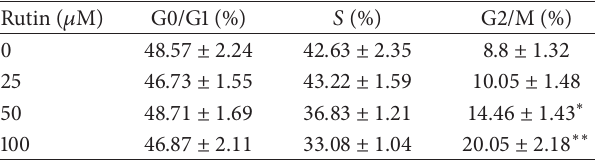
Table 1: The effect of rutin on cell